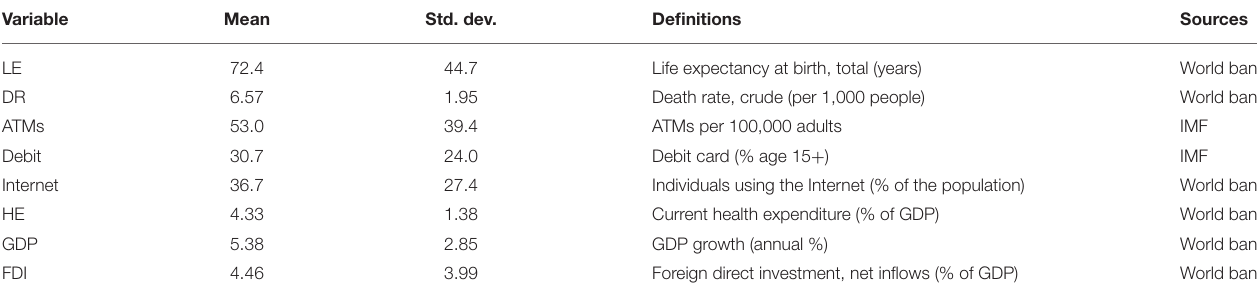
TABLE 1 | Descriptive statistics and definitions.